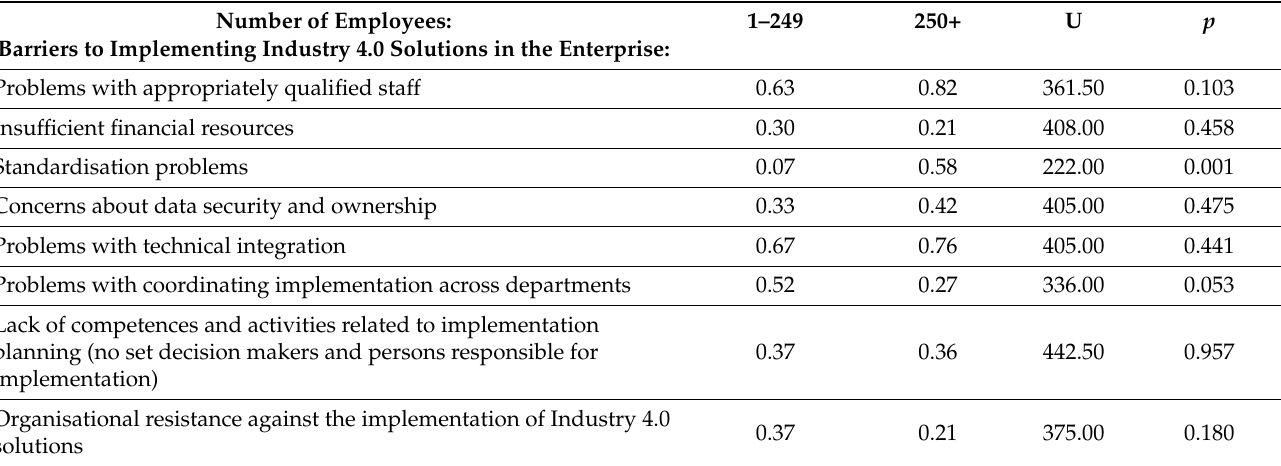
Table 6. Assessment of barriers to implementing Industry 4.0 solutions in the enterprise in companies employing up to 249 participants and in companies employing at least 250 participants.